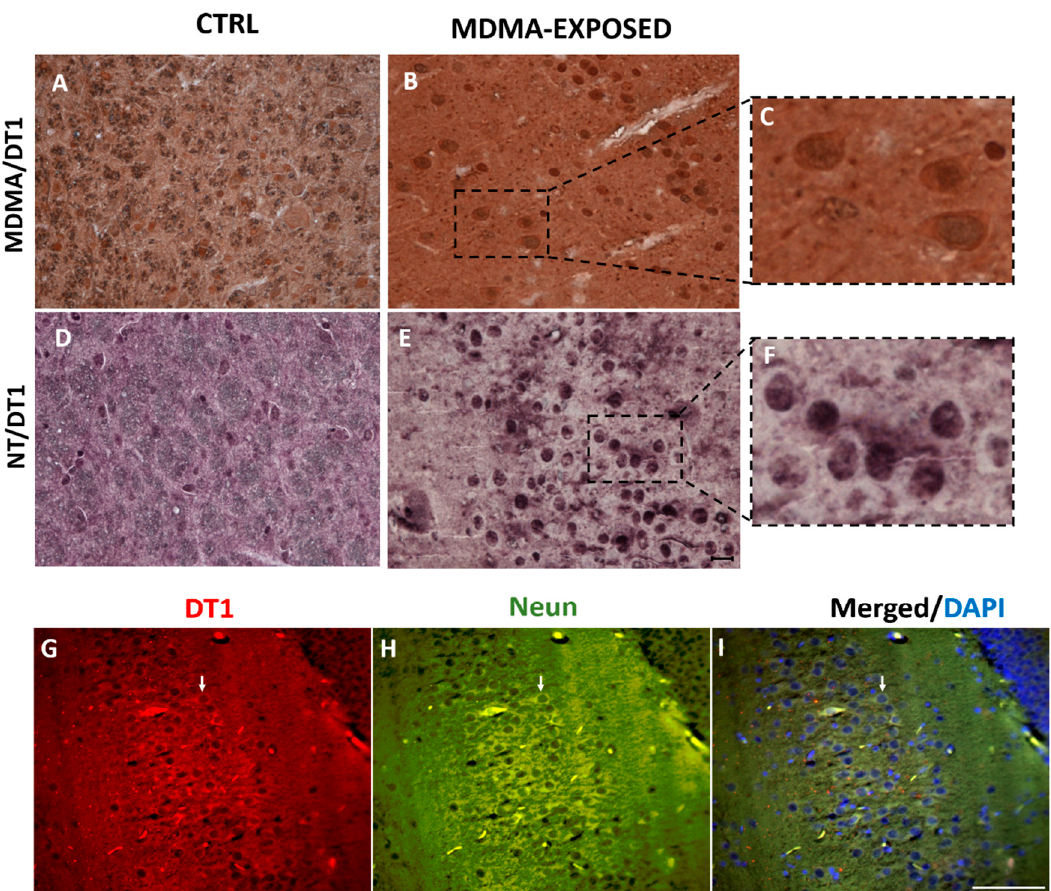
Figure 4. MDMA and NT colocalized with dopamine transporter (DT1). ( A , B ) Representative images (light microscopy, 40 × ) of MDMA/DT1 double immunostaining in the frontal cortex of rats receiving ( A ) saline (CTRL) and of rats receiving ( B ) MDMA (MDMA-exposed, sacrificed after 6 h). ( C ) Blown-up image of the dotted area highlighted in ( B ). ( D , E ) Representative images (light microscopy, 40 × ) of NT/DT1 double immunostaining in the frontal cortex of rats receiving ( D ) saline (CTRL) and in rats receiving ( E ) MDMA (MDMA-exposed, sacrificed after 6 h). ( F ) Blown-up image of the dotted area highlighted in ( E ). Scale bar for images in ( A , B , D , E ) = 50 μ m. ( G – I ) Representative images (light microscopy, 40 × ) of DT1 ( G -red staining)/NeuN ( H -green staining) immunofluorescence and merged images with 4 ′ , 6-diamidino-2-phenylindole (DAPI) ( I -blue staining) in the frontal cortex. Scale bar for images in ( G – I ) = 100 μ m. Arrows indicate a representative DT1/NeuN double-stained cell.